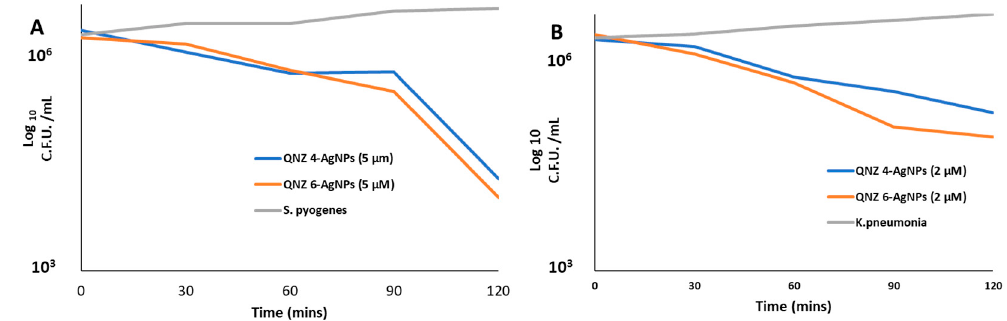
Figure 8. Antimicrobial e ff ect of QNZ nanoparticles against S. Pyogenes ( A ) and K. Pneumonia ( B ). Both concentrations of nanoparticles were applied to approx. 10 8 colony forming units (C.F.U.) per mL of bacteria. At different times after the treatment, viable cell counts were measured by culturing bacterial colonies on agar plates. Each of the CFU/mL value represents the mean of three replicates.